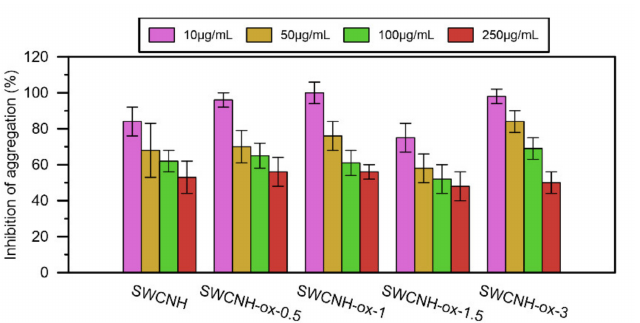
Figure 6. The results of the inhibition of platelet aggregation by SWCNH-ox materials in concentra- tions 10–250 µ g/mL compared to the control (100%).